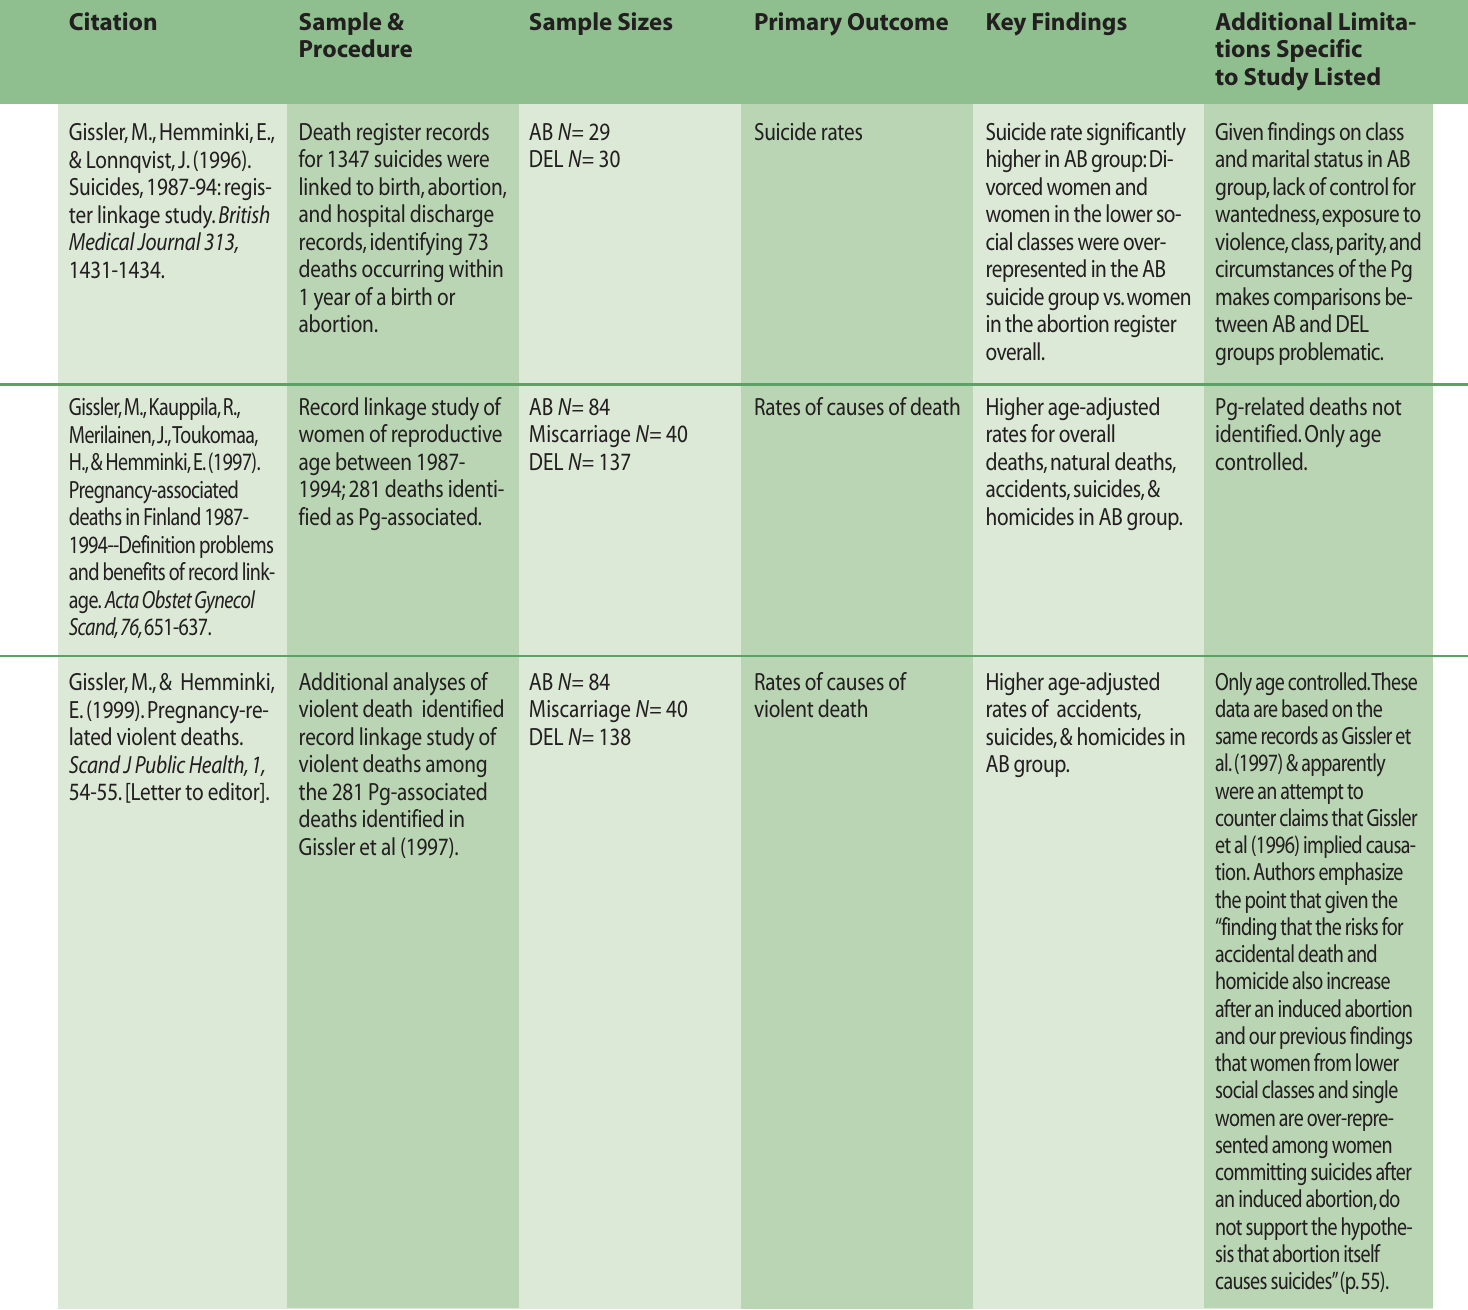
Table 1: Medical Records–Abortion vs.Comparison Groups INTERNATIONAL